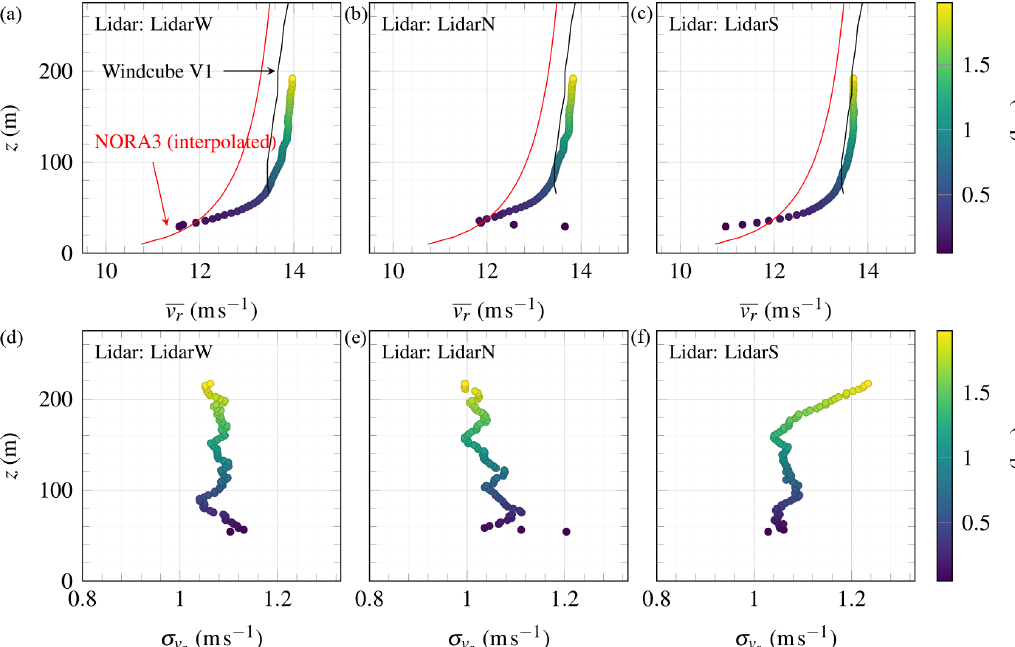
Figure 16. (a, b, c) Mean wind speed recorded along the beams of the scanning lidar units (scatter) superposed to the wind profile of the WindCube V1 and the NORA3 hindcast 3km away from the coast (solid lines). (d, e, f) Standard deviation of the along-beam component at increasing distances and heights on 25 October 2019 from 13:35 to